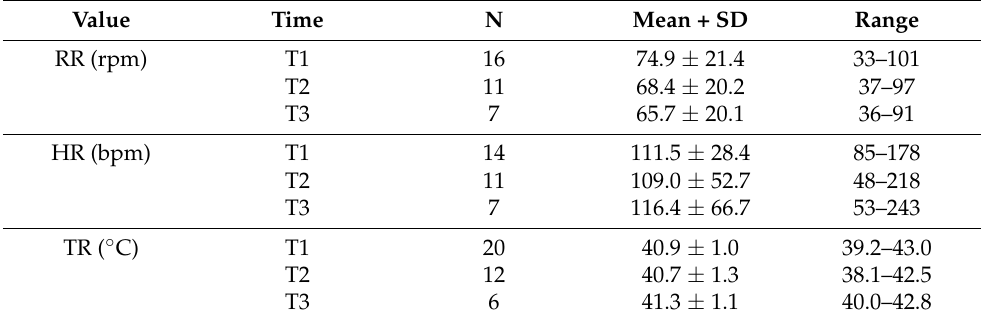
N: sample size; SD: standard deviation; RR: respiratory rate; HR: heart rate; TR: rectal temperature; rpm: respirations per minute; bpm: beats per